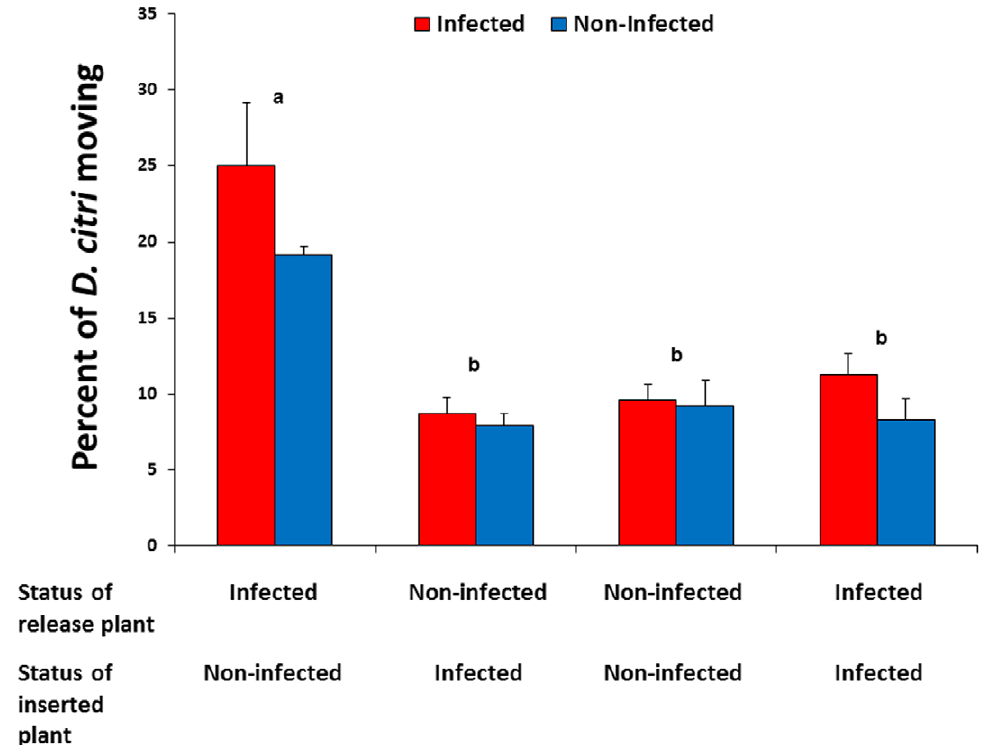
Figure 3. Movement of previously settled D.citri from Las-infected to non-infected citrus plants. Red bars show the response of Las- infected psyllids and blue bars show the response of non-infected psyllids; no significant differences were detected between psyllid types within plant treatments. Pairs of bars representing plant treatment combinations labeled with different letters are significantly different from one another (Tukey’s HSD test, p ,